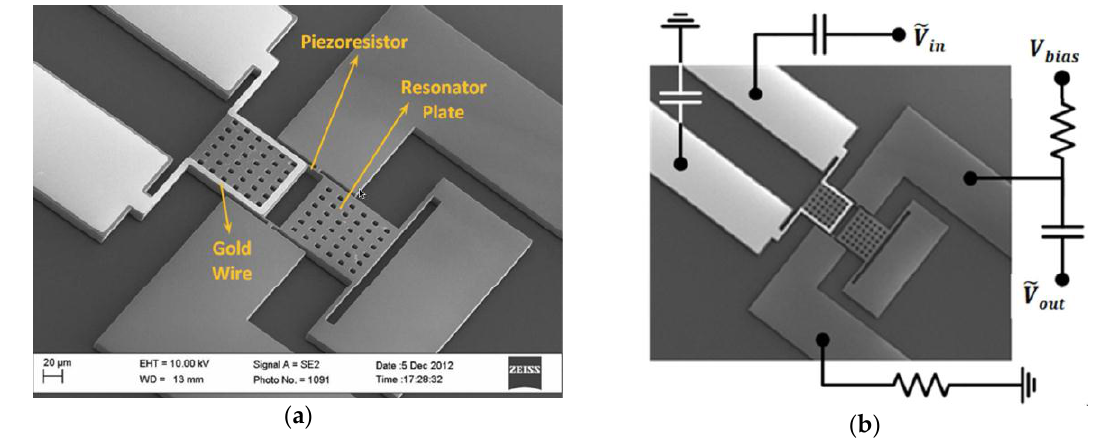
Figure 8. SEM image of the ( a ) main elements of a MEMS magnetic field sensor with piezoresistive readout, which is composed by a dual-plate silicon resonator with a gold trace and piezoresistors; ( b ) Electrical connections of the magnetic field sensor [26]. Reprinted with permission from [26]. Copyright© 2014, IEEE.